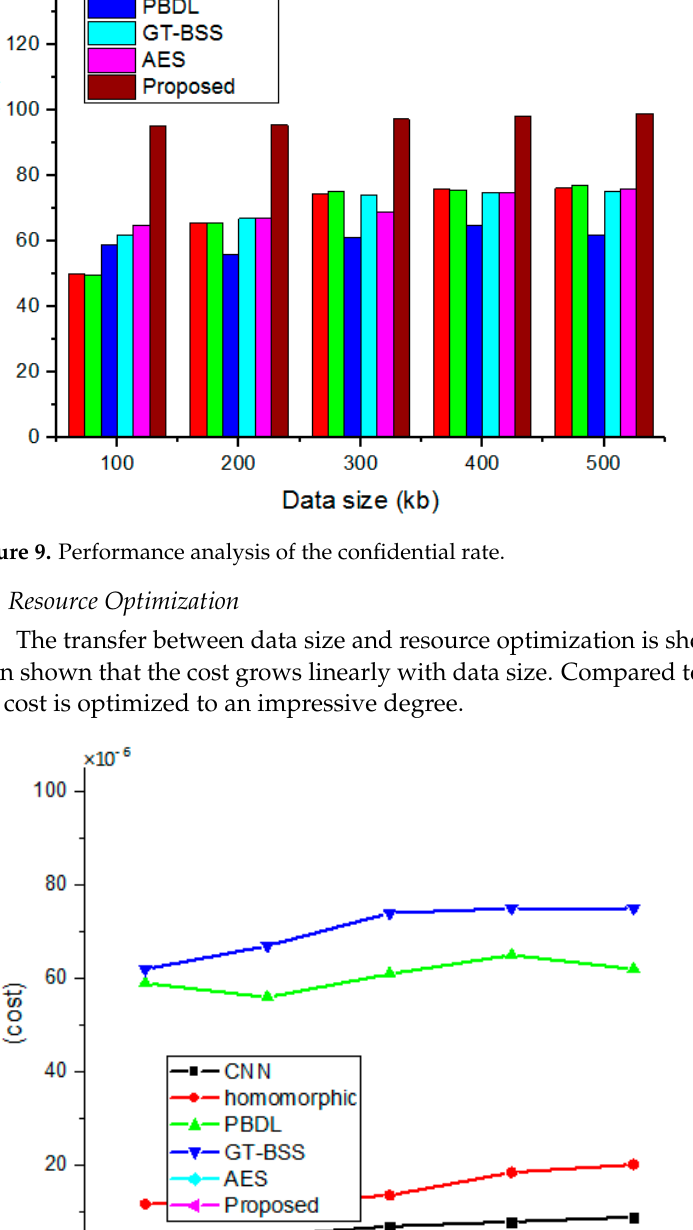
Figure 10. Correlation between data size and resource optimization.